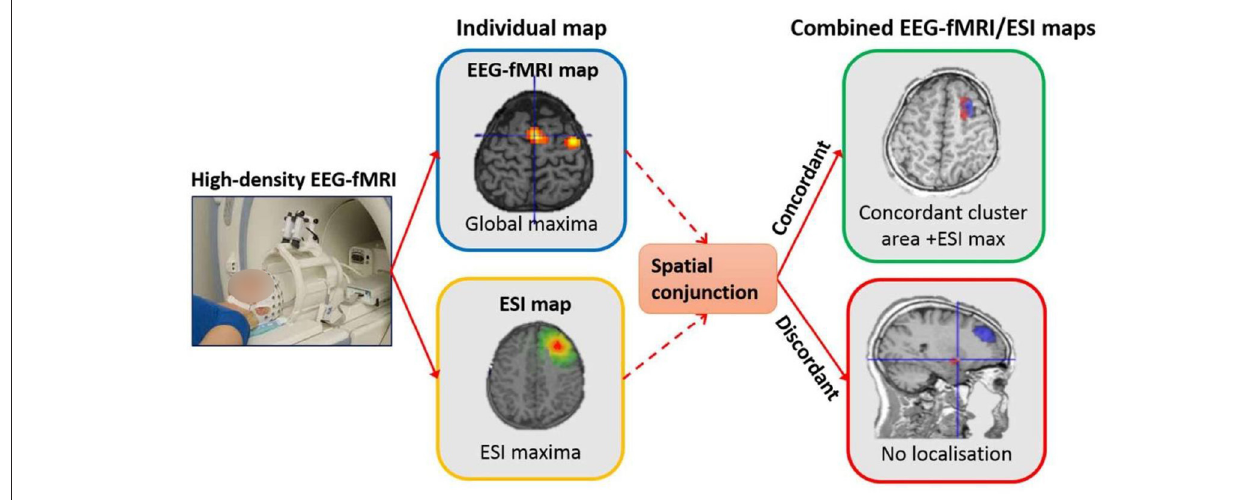
FIGURE 12 | Localization extraction procedure from left to right. For the individual map of EEG–fMRI, the result of localization based on global maxima is shown. Also, for the individual map of ESI, the same result based on maxima in the map from the 50% rising phase of the IED is shown. For the combined test, the spatial conjunction of both maps was used for the localization. Only for the concordant maps, the result of combined localization was extracted from the region encompassing the ESI max and the closest significant EEG–fMRI cluster located in the same sub-lobe (137).